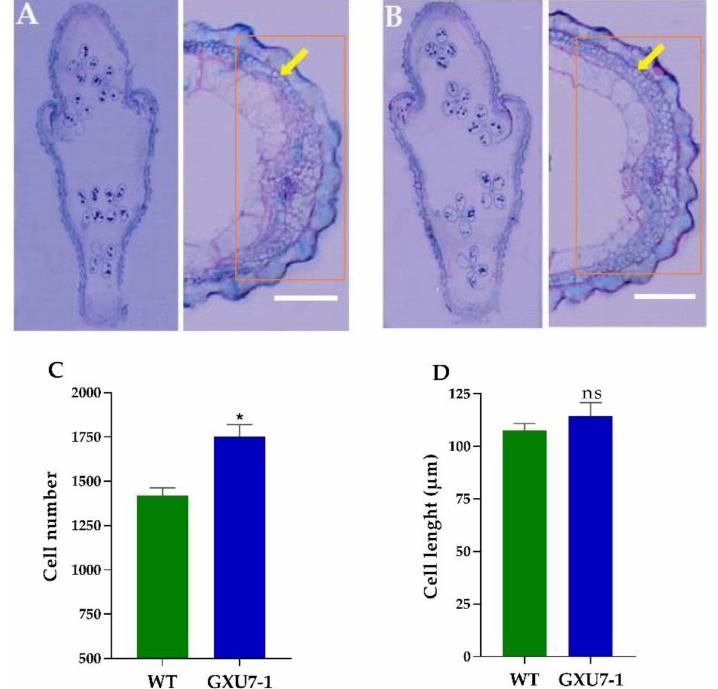
Figure 4. Anatomical observation and comparison of wild-type (WT) and mutant line (GXU7-1) grain cells. Transverse section of whole grain and paraffin section of the developed lemmas of WT ( A ) and GXU7-1 ( B ), respectively. ( C ) Cell number of the lemma. ( D ) Cell length of the outer epidermal lemma. Data are given as means ± SD, n = 5, p ≤ 0.01. * and ns represents significant and non-significant difference,